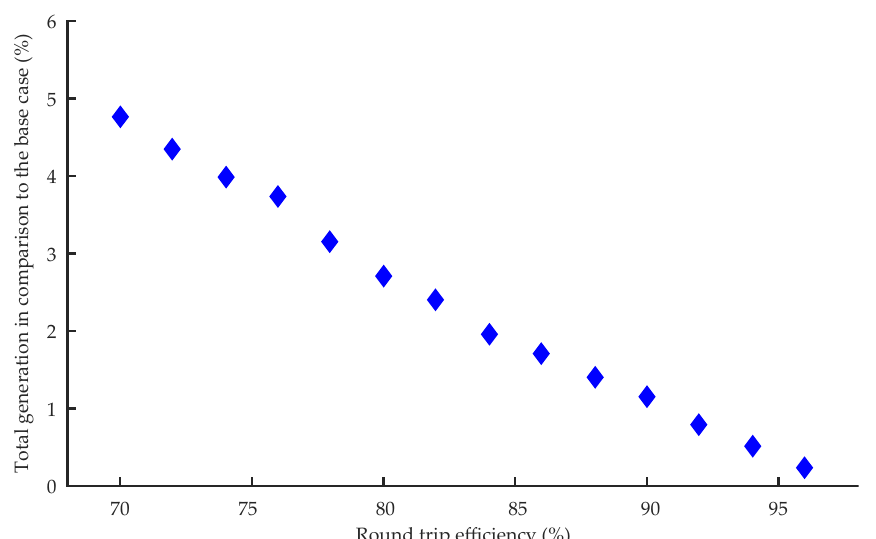
Figure 7. Total generation variation with the round trip efficiency for the case of four diesel generators with batteries in comparison to the base